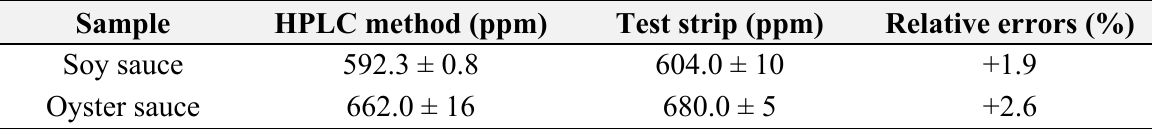
Table 3. Determination of benzoic acid in sauce samples by the developed test strip and HPLC